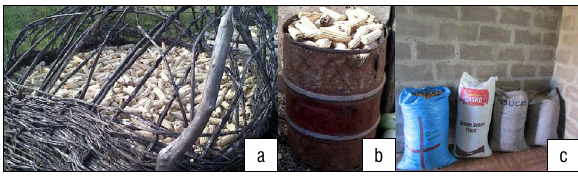
Figure 6: Common storage facilities for maize utilised by subsistence farmers in districts of northern KwaZulu-Natal: (a) inqolobane, (b) metal drum and (c) groundnut bags.